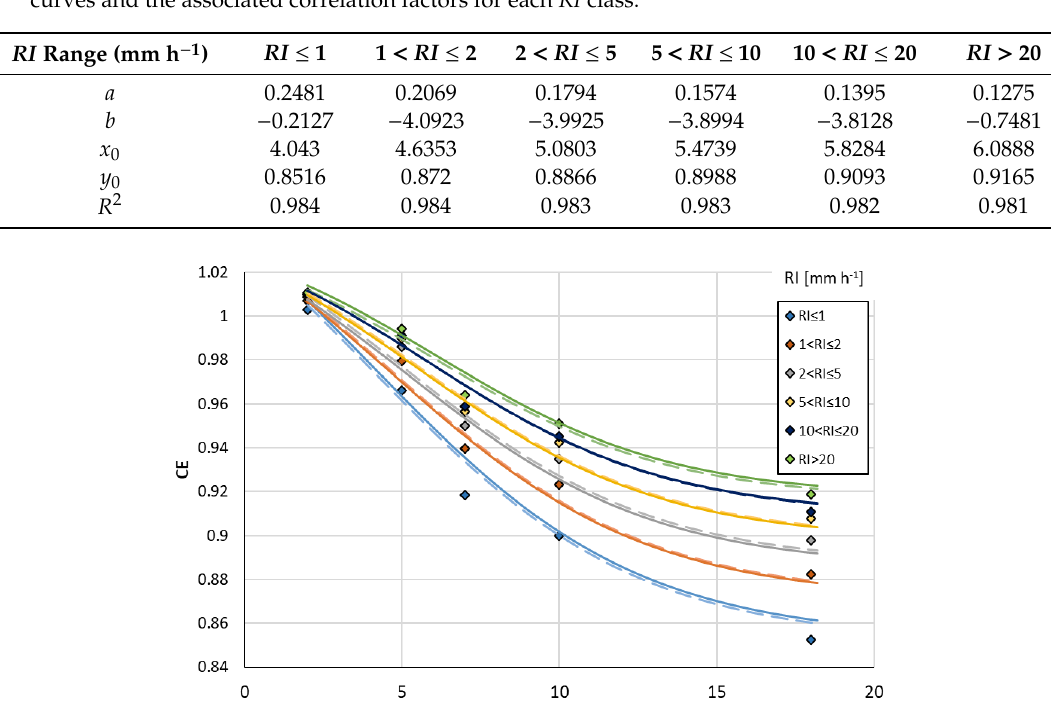
Table 5. Parameters of the sigmoidal functions obtained by using N 0 ( RI ) and Λ ( RI ) as power law curves and the associated correlation factors for each RI class.